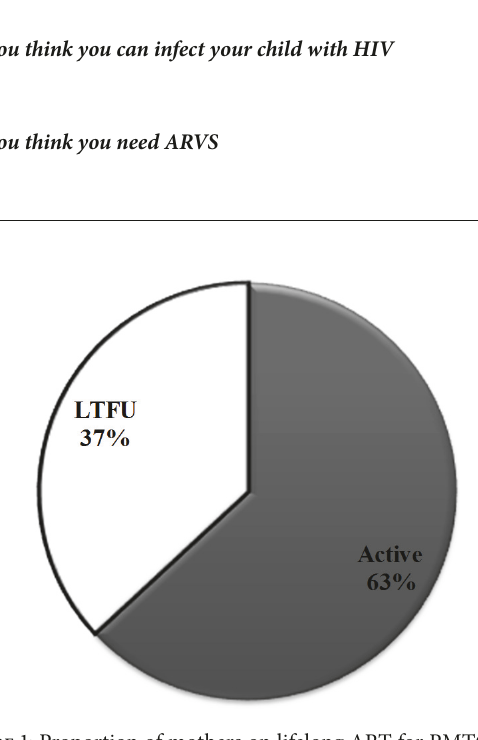
Figure 1: Proportion of mothers on lifelong ART for PMTCT who were lost to follow-up between Sept 2013 and Sept 2015, n=